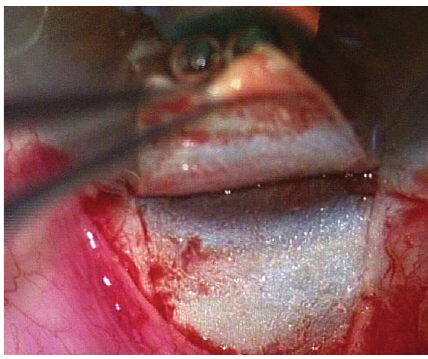
Figure 1: Dissection of the superficial sclera flap.